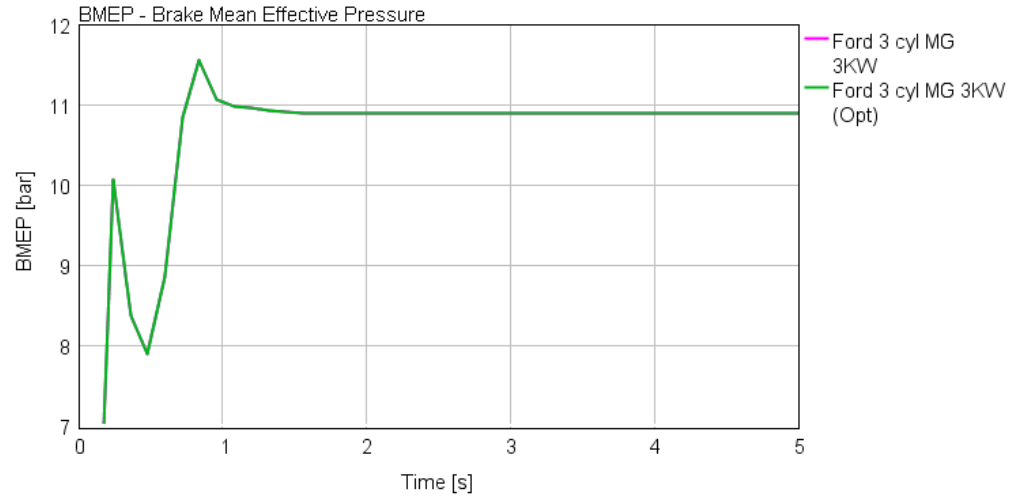
Figure 25. Brake torque of the electrically-assisted turbocharger (EAT) 4 kW model for the initial and optimized compressor.